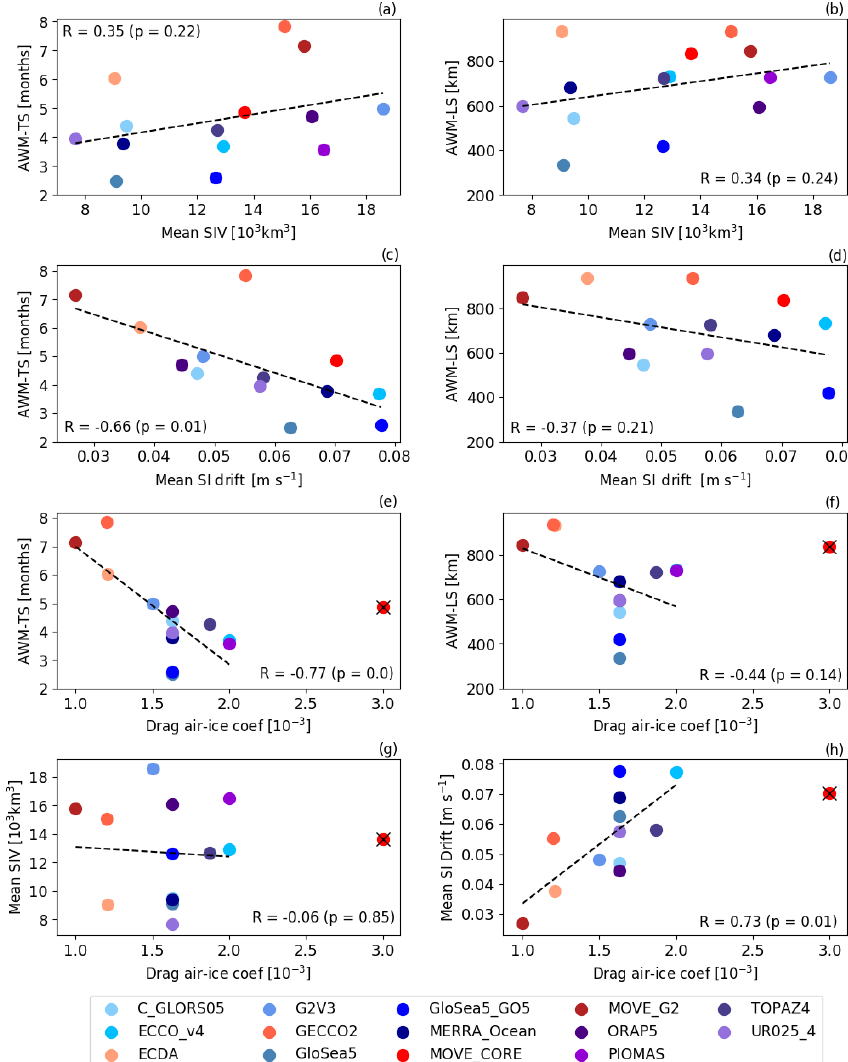
Figure 13. Scatter plots showing how the (a, c, e) AWM timescale and (b, d, f) AWM length scale are related to the (a, b) mean state, (c, d) mean sea ice (SI) drift, and (e, f) drag air–ice coefficient. (g) Relation between drag air–ice coefficient and mean state. (f) Relation between drag air–ice coefficient and mean sea ice drift. Black dashed lines indicate the linear fit, while the coefficient of correlation R (and its respective p value) is also displayed in each panel. The black cross in panels (e) – (h) indicate that MOVE-CORE was not used in the respective regressions (black dashed lines), since this reanalysis adopts a much higher drag air–ice coefficient compared to the other 13 reanalyses. Shades of blue and purple indicate the reanalyses which do assimilate sea ice data, while shades of red indicate the reanalyses without sea ice data